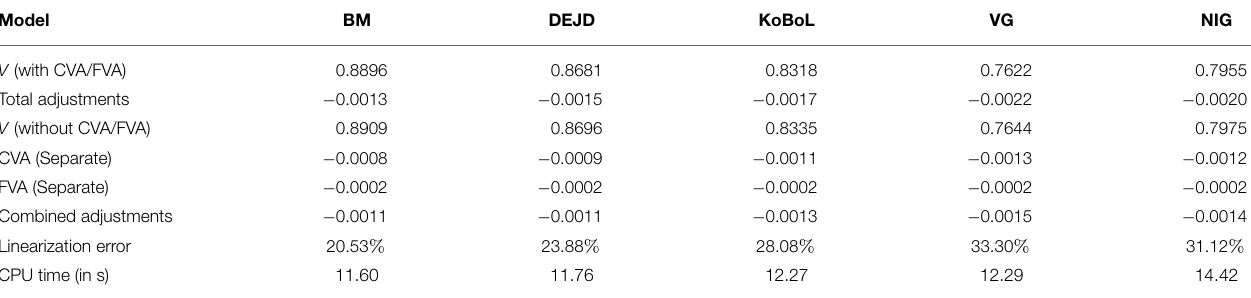
TABLE 13 | Prices of first-touch digitial for different models as of 9 January 2015, time to maturity T = 0 . 463 , spot S = 24 , 000 , barrier H = 23 , 500 , risk-free rate r = 0 . 52 % , collateral rate r C = 1 % , funding rate r F = 1 . 7 % default intensity λ = 0 . 05 , recovery rate R B = 0 . 4 , collateral threshold H B = 0 . 5 .